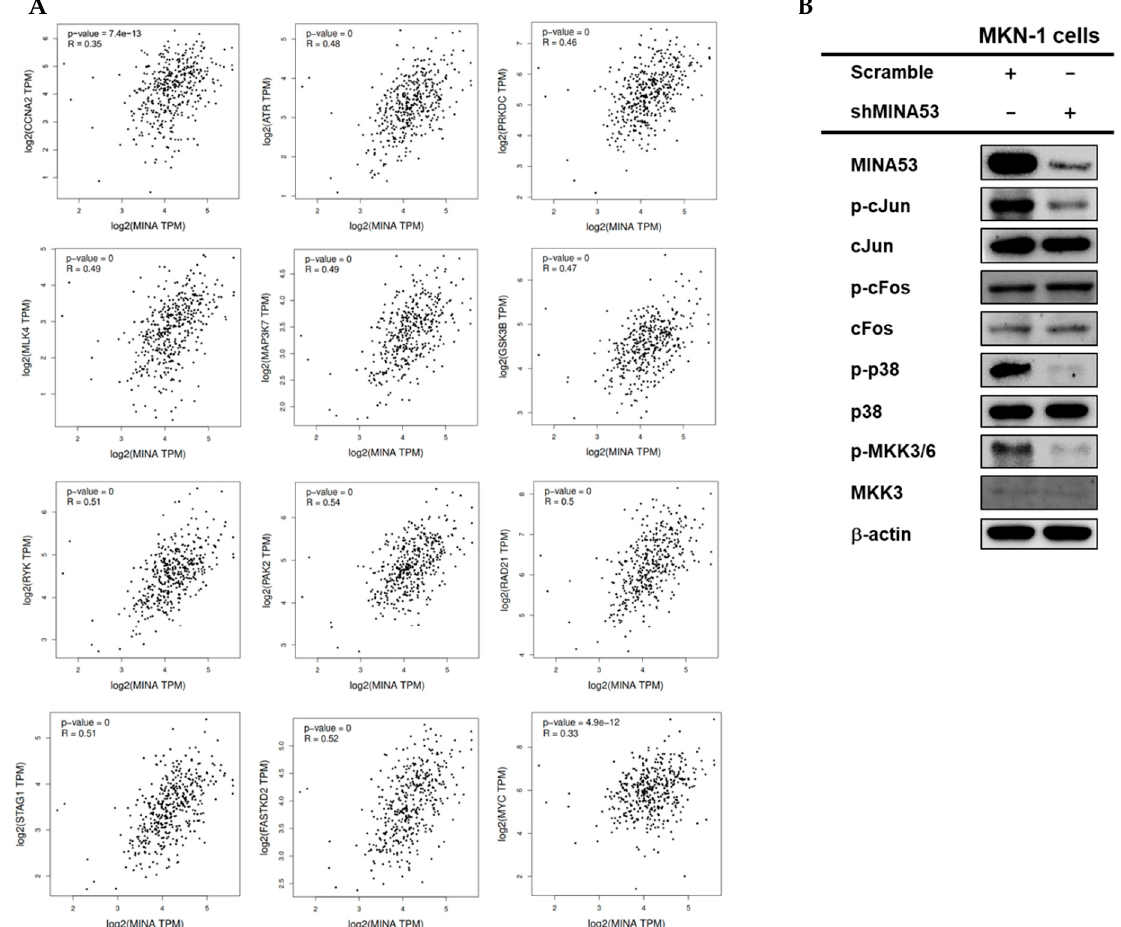
Figure 7. Regulatory role of MINA53 in AP-1 signaling in gastric cancer cell lines. ( A ) Gene expression correlation with JMJD10 in the STAD tumor dataset using GEPIA. ( B ) Immunoblot analysis of AP-1 signaling activation in MINA53-silenced MKN-1 cells. The whole Western blot images please find in Figure S1.